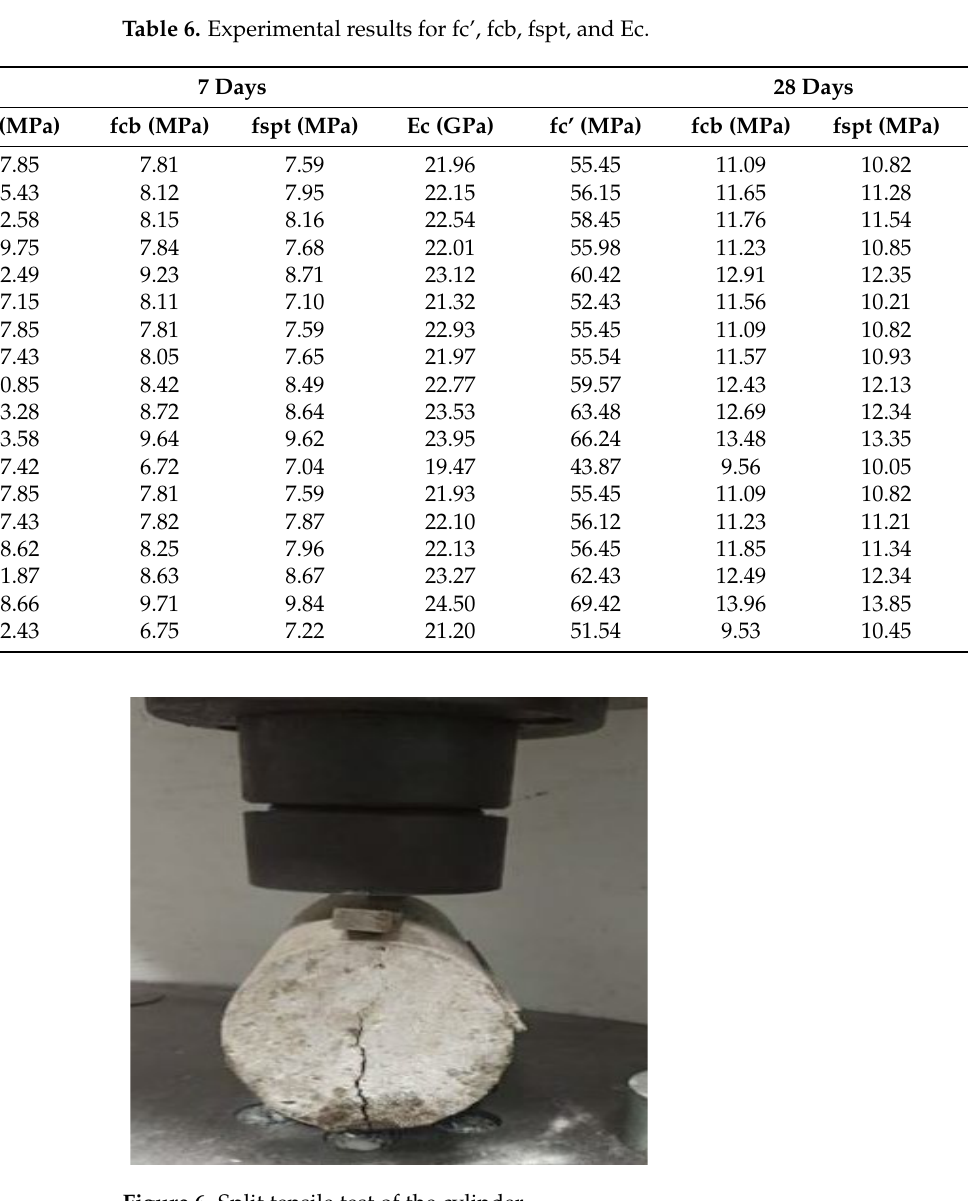
Figure 6. Split tensile test of the